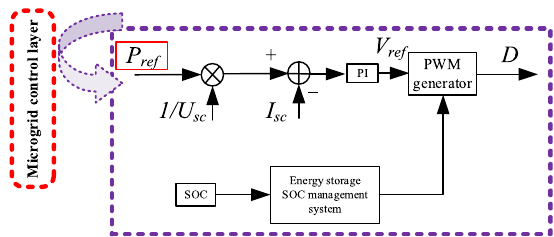
Fig. 7 Energy storage power loop control strategy